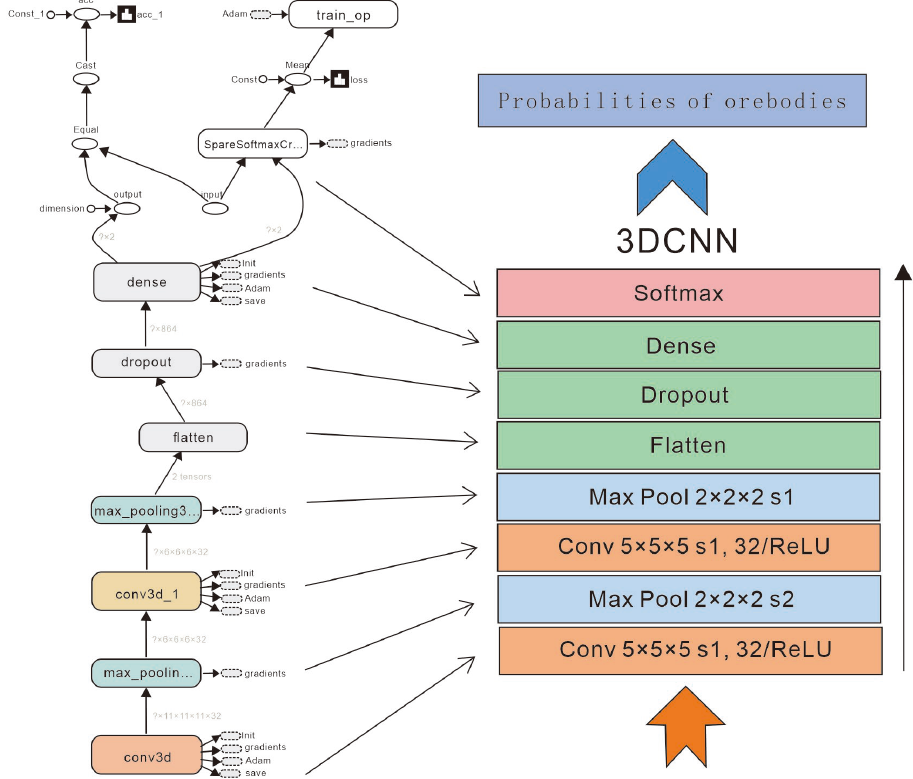
Figure 7. The network structure and parameters of the 3D CNN.